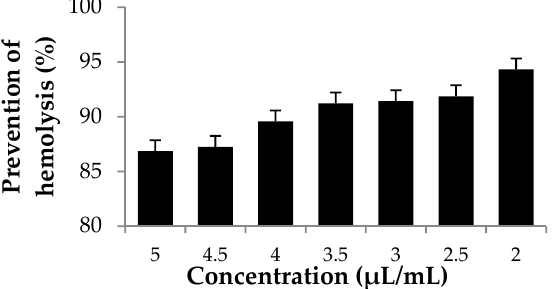
Figure 4. Effect of thyme essential oil on hyposaline induced hemolysis in red blood cells (RBC). Values are expressed as mean ± SD of triplicate experiments.